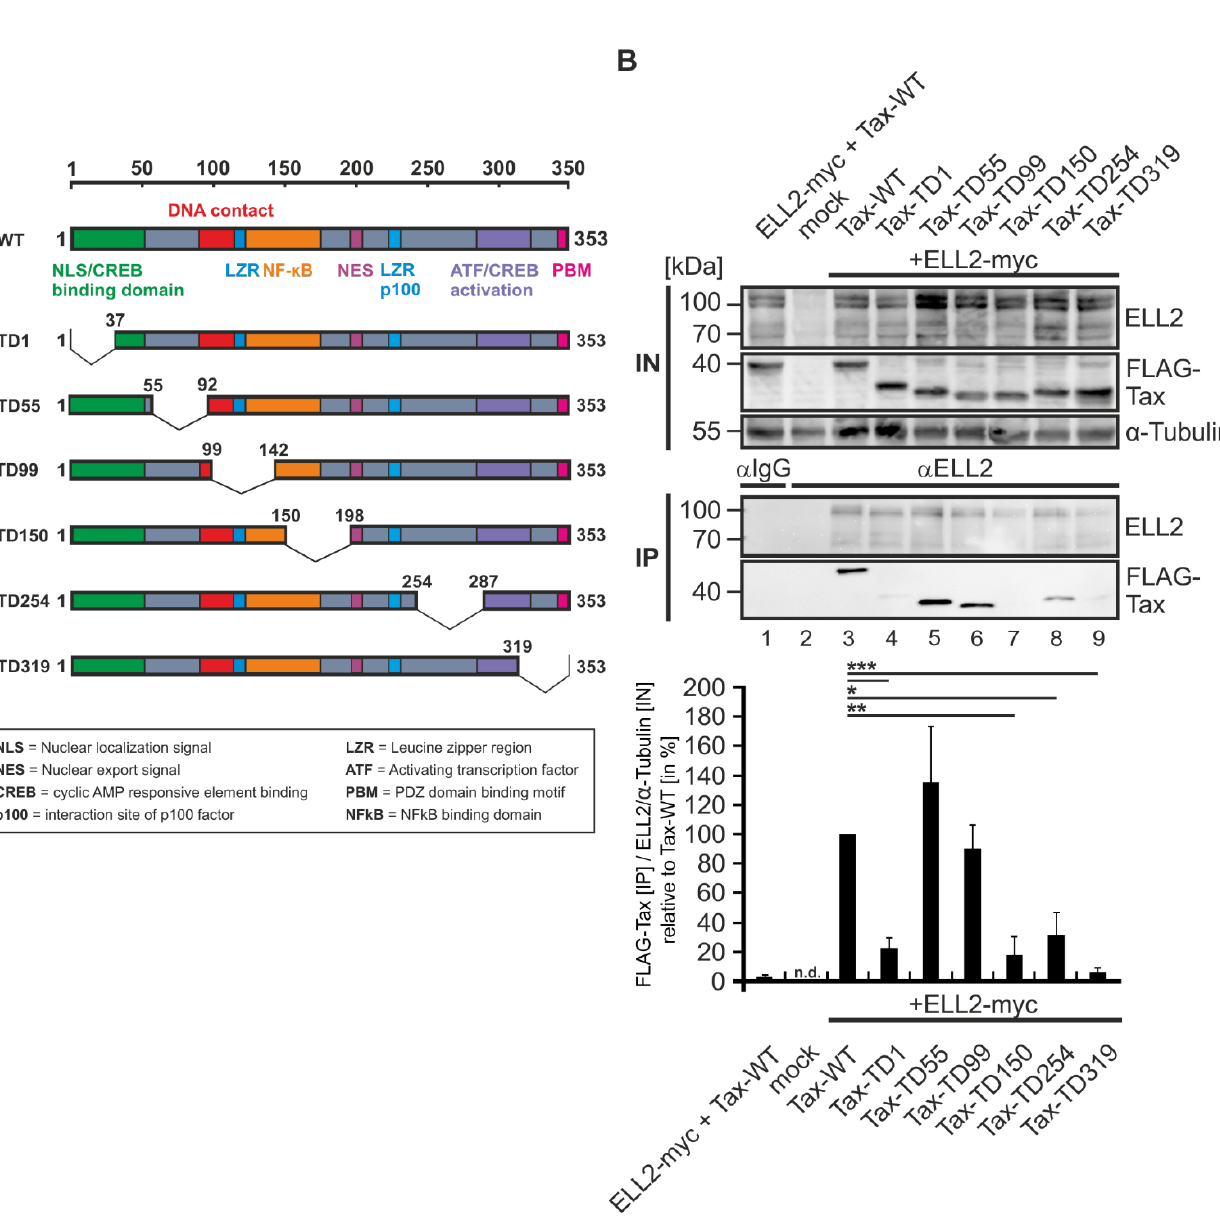
Figure 3. N-terminal (aa 1–37) and C-terminal (aa 150–353) domains of Tax-1 are critical for Tax-1:ELL2 complex formation. ( A ) Schematic representation of Tax-1-wildtype (WT) and six truncation mutants harboring deletions beginning from the N-terminus (TD1) to the C-terminus (TD319) of the Tax sequence. Numbers indicate amino acids of Tax-1. ( B ) 293T cells were transfected with 1 µg of the FLAG-tagged expression plasmids pCAG-FLAG-Tax-WT (Tax-WT), Tax truncations pCAG-FLAG-Tax-TD1 (Tax-TD1), pCAG-FLAG-Tax-TD55 (Tax-TD55), pCAG-FLAG-Tax-TD99 (Tax- TD99), pCAG-FLAG-Tax-TD150 (Tax-TD150), pCAG-FLAG-Tax-TD254 (Tax-TD254), and pCAG-FLAG-Tax-TD319 (Tax- TD319) together with pEF-ELL2-myc (ELL2-myc; 1µg) or the respective empty control vectors pCAG-FLAG and pEF